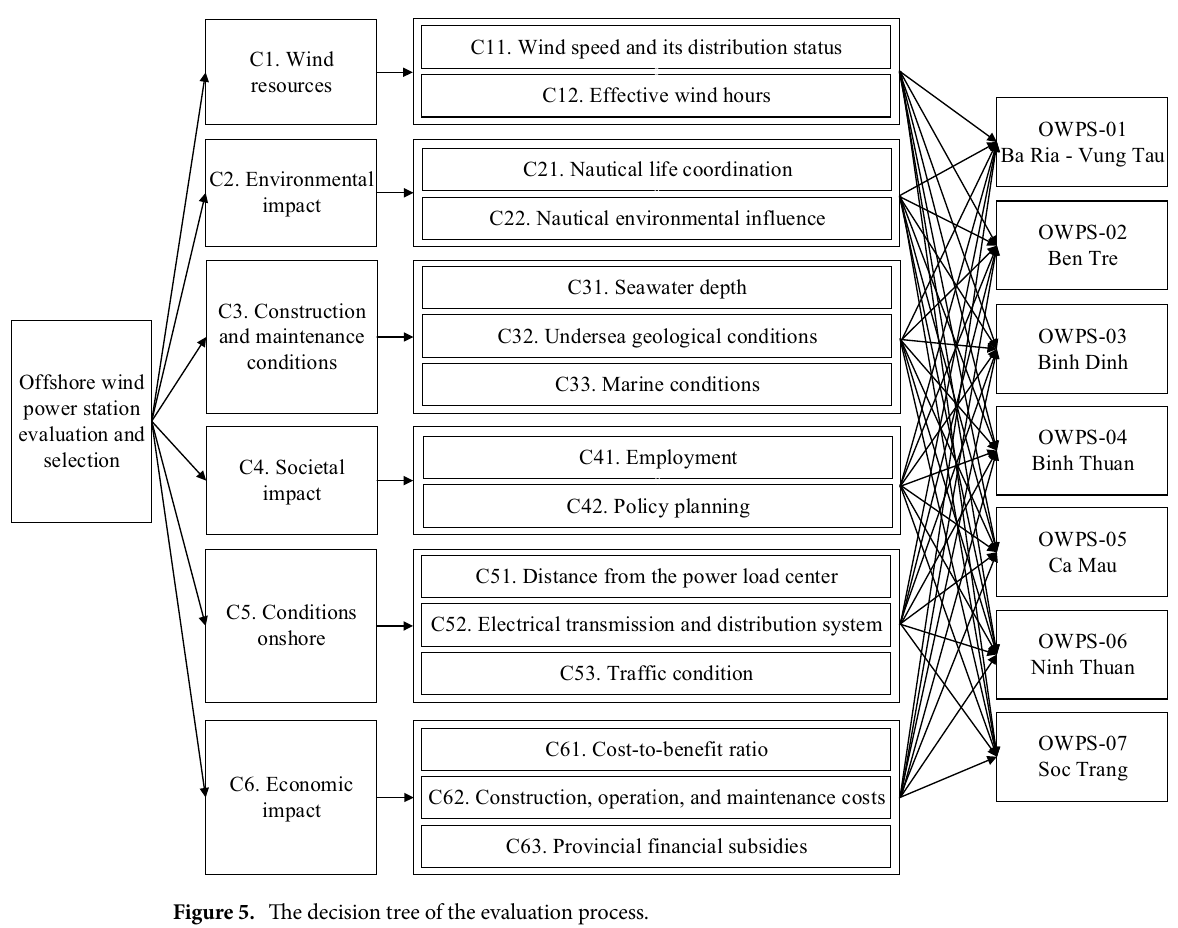
Figure 5. The decision tree of the evaluation